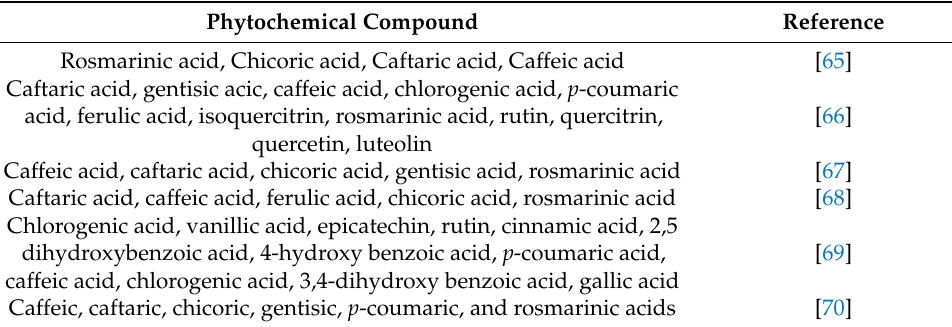
Table 2. Chemical composition of O. basilicum